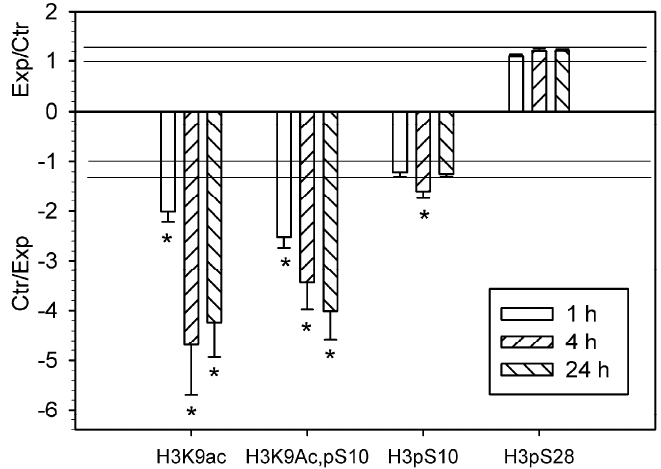
Figure 1. The ratios of the levels of acetylated or phosphorylated histone H3 in the ischemic penumbra 1, 4 or 24 h after photothrombotic stroke in the rat cerebral cortex (Exp) to that in the untreated contralateral cortex of the same animals (Ctr). H3K9Ac—histone H3 acetylated on lysine 9; H3K9Ac,pS10—histone H3 acetylated on lysine 9 and phosphorylated on serine 10; H3pS10—histone H3 phosphorylated on serine 10; H3pS28—histone H3 phosphorylated on serine 28. The antibody microarray data. n = 16 (4 animals × 4 values in each experiment). Mean ± SD. * p < 0.05.